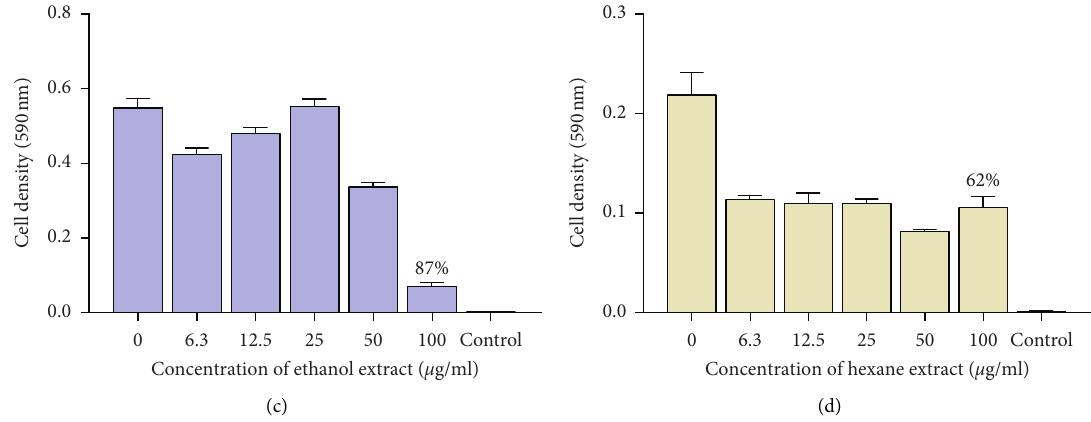
Figure 2: The effects of extracts of pods of P. thonningii against M. smegmatis : (a) effect of acetone extract, (b) effect of DCM extract, (c) effect of ethanol extract, and (d) effect of hexane extract. Concentrations of extract ranged from 6.3 μ g/mL to 100 μ g/mL. Values are in mean cell density at 590 nm wavelength ± the standard deviation; N � 4.